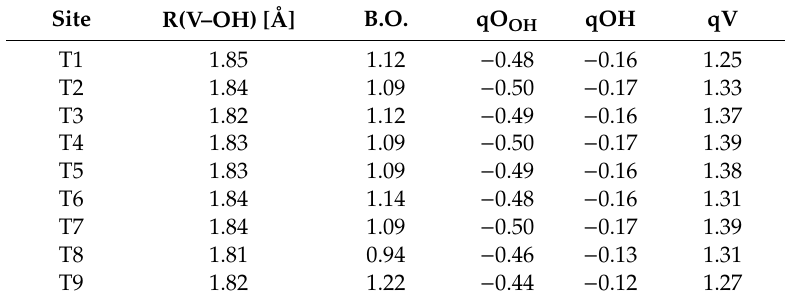
Table 2. Structural parameters of the V–OH group introduced to different crystallographic positions in BEA zeolite.